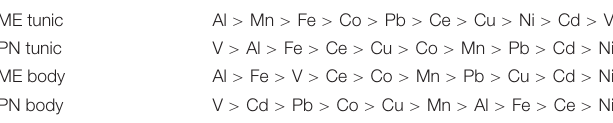
TABLE 2 | The mean BAF of M. exasperatus (ME) and P. nigra (PN) body and tunic, arranged in decreasing order, based on samples collected in Akko, Mikhmoret, and Eilat.